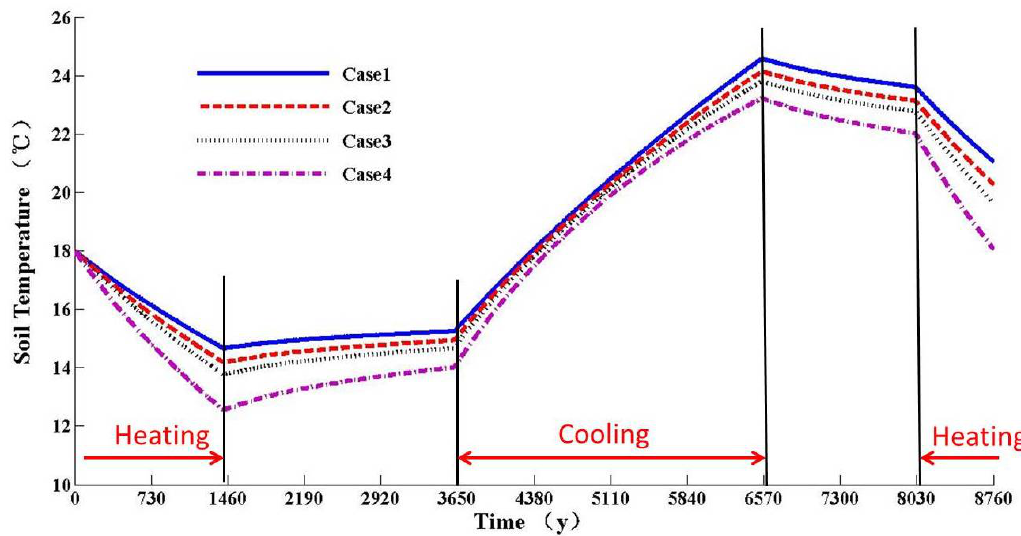
Figure 5. Average soil temperatures in the first year of operation.